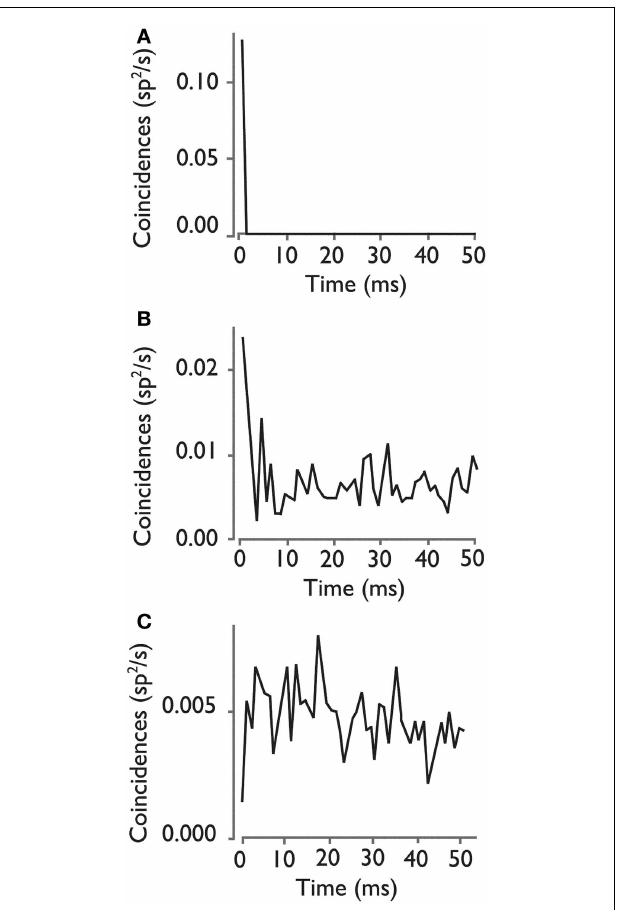
FIGURE 4 | Cross-correlograms for three pairs of HH neurons . (A) Rate of coincident firing as a function of the delay between firing for a neuron pair with a significant high level of synchronous firing. (B) Cross- correlogram for neuron pair with an insignificant level of synchronous firing, showing the types of peaks that can randomly occur in a cross-correlogram. (C) Cross-correlogram for a pair of neurons with a significant inhibition of synchronous firing at 0 delay. Used with permission from Barrow Neurological Institute.